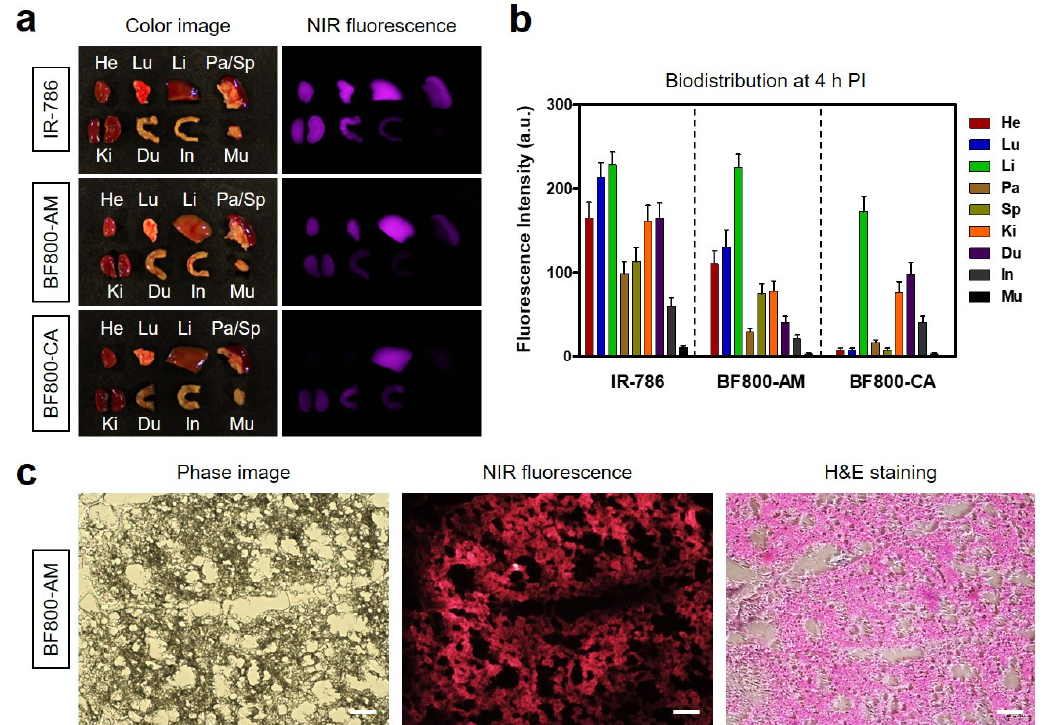
Figure 6. In vivo biodistribution of IR-786, BF800-AM, and BF800-CA NIR dyes. ( a ) Resected organs imaged 4 h after injection of each NIR dye. ( b ) Quantitative fluorescence analysis of intraoperative dissected organs 4 h post-injection of each NIR dye. Abbreviations: Du, duodenum; He, heart; In, intestines; Ki, kidneys; Li, liver; Lu, lungs; Mu, muscle; Pa, pancreas; Sp, spleen; PI, post-injection. ( c ) Phase contrast imaging, NIR fluorescence imaging, and H&E staining of the resected BAT sample 4 h after injection of BF800-AM. Scale bars = 100 µm. Images are representative of three independent experiments. All NIR fluorescence images have identical exposure times and normalization.